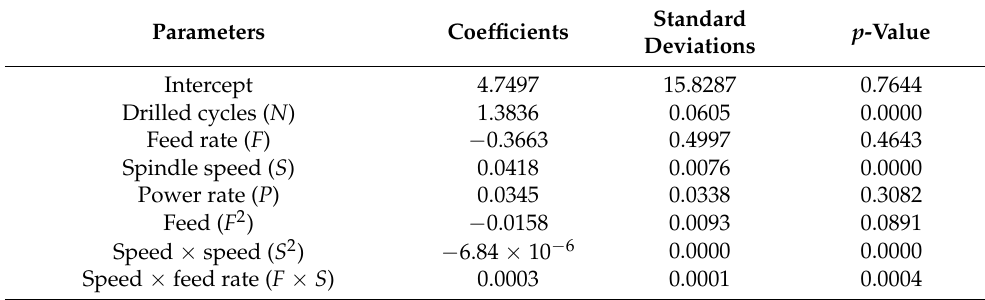
Table 6. Regression coefficients for the cutting force model in nonlinear polynomial function.